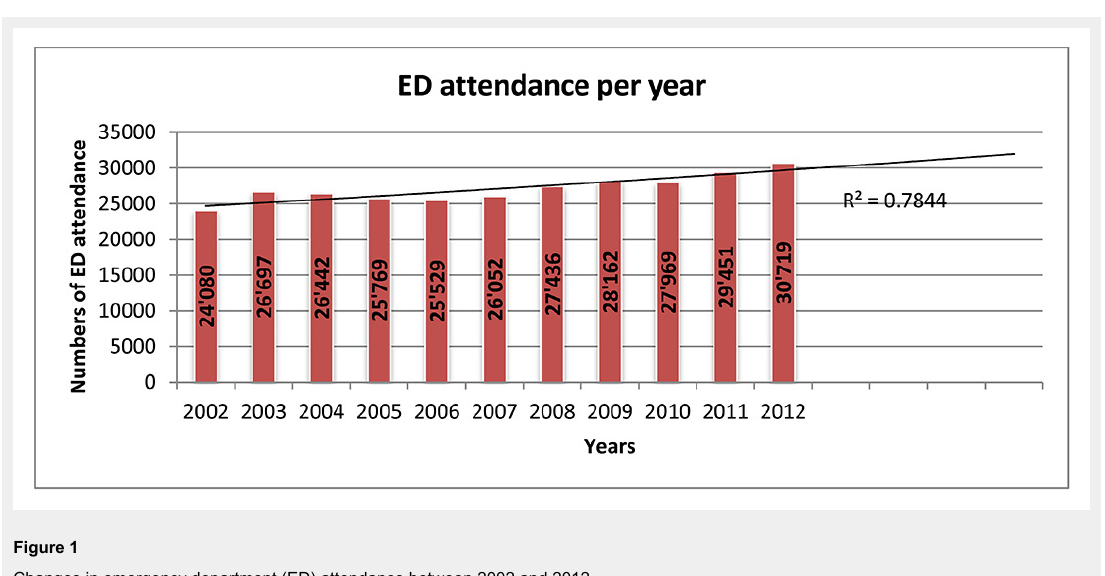
Figure 1 Changes in emergency department (ED) attendance between 2002 and 2012. The numbers of ED attendance from 2002 to 2012 of all patients are provided. Each bar represents one year, as indicated by the x-axis. The numbers within each bar represent the numbers of patients attending the ED within that particular year. The line represents the trend of an exponential regression with the calculated coefficient R 2 =0.7844 of the overall ED attendance based on the existing data. It is probable that ED attendance will continue to grow.